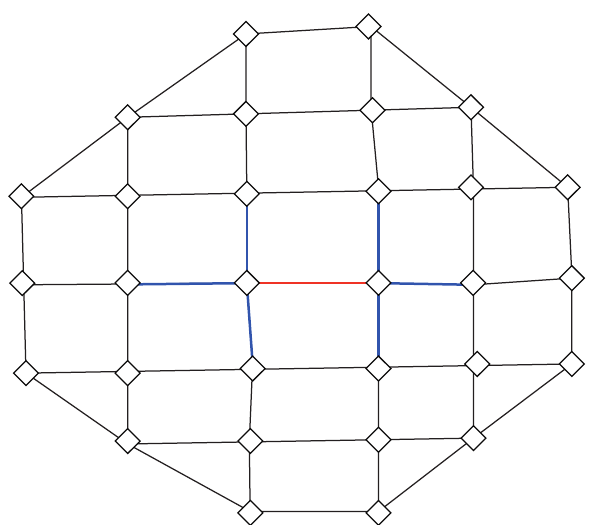
Figure 1: Schematic diagram of the algorithm.